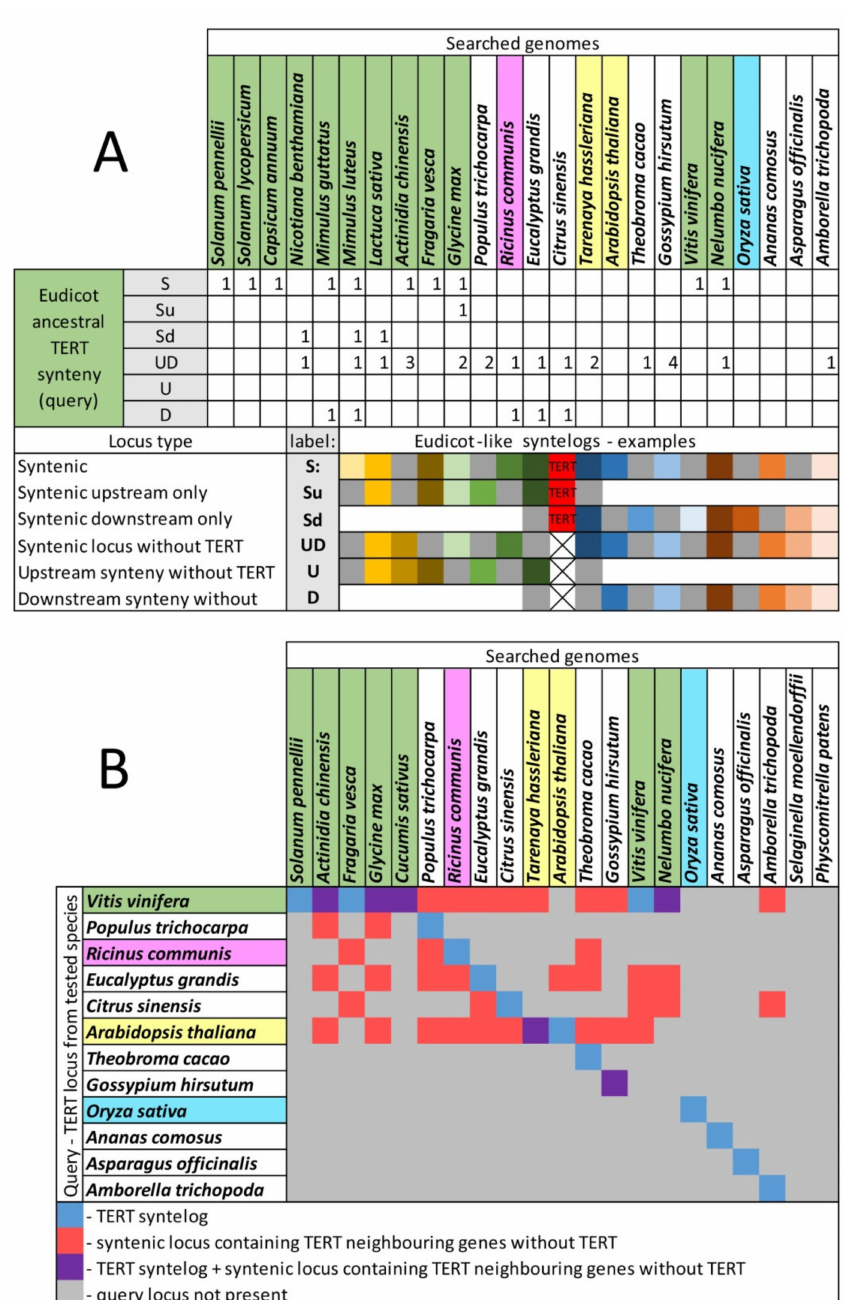
Figure 6. Occurrence of TERT syntelogs in Angiosperms. ( A ) Detailed analysis of the eudicot-like type of synteny (represented by Vitis syntelog as a query) in indicated genomes shows the presence of syntenic regions with/without the TERT gene in the majority of investigated eudicots and Amborella . The number of syntelogs and synteny categories are shown for each species. ( B ) The occurrence of conserved syntenic regions corresponding to the species-specific TERT query was investigated in representative genomes. Co-occurrence of syntelogs in more species suggests an ancient origin of target loci that accommodated TERT in current species. Analyses were carried out using CoGe, GEvo and SynFind. SynFind parameters—algorithm: last; Gene window size: 30; minimum number of genes: